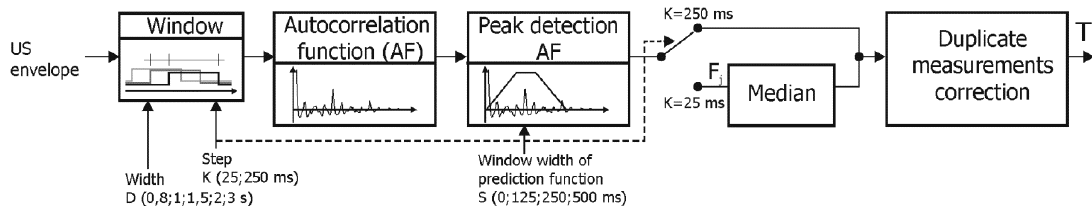
Figure 6. General block diagram of the D1 algorithm for determining the instantaneous value of fetal heart rate (T i interval) based on a raw Doppler US signal.